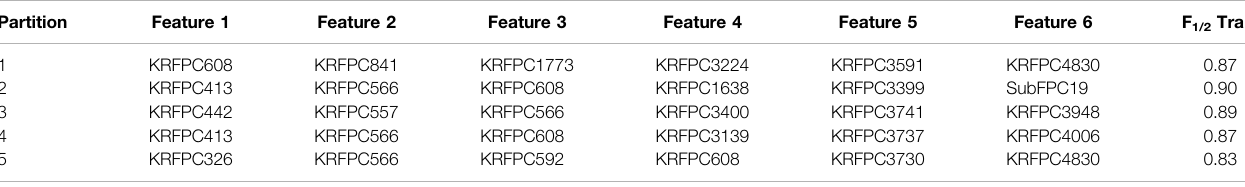
TABLE 2 | Best set of features ( “ Selected features ” , see Figure 2 ) obtained on each partition of the cross validation split based on the training F 1/2 score for the LDA model.